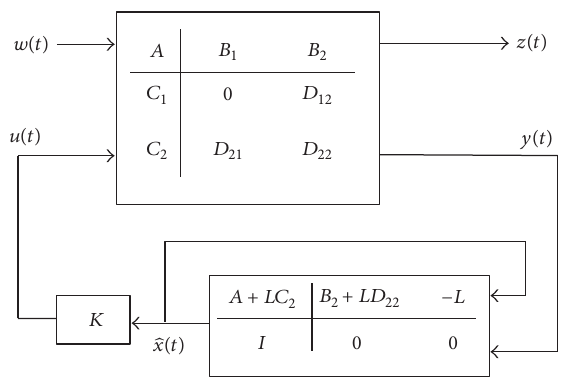
Figure 2: Structure of the observer based